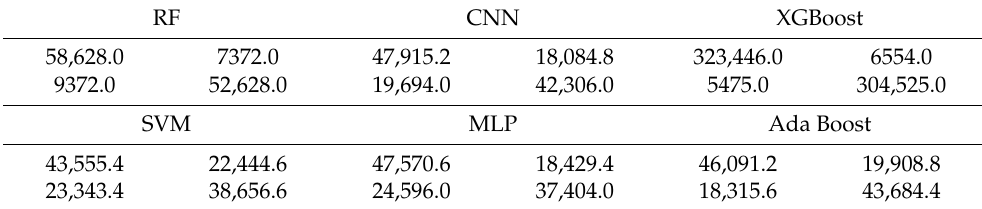
Table A3. Two Classes, Tubers Differentiation.